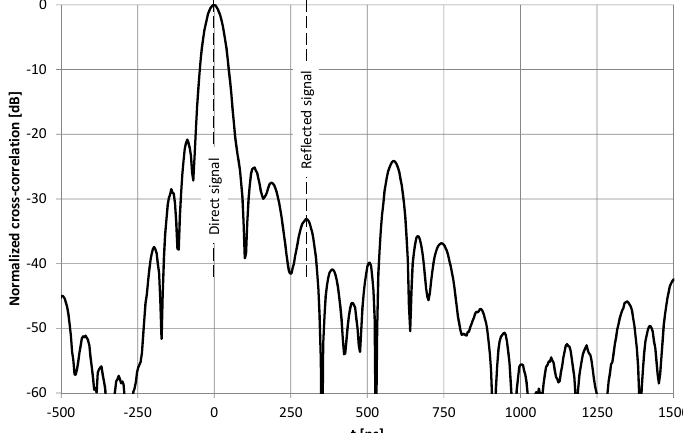
Figure 3. Example of a cross-correlation function of a signal recorded at d 1 = 13.3 m using an unterminated radiating cable.